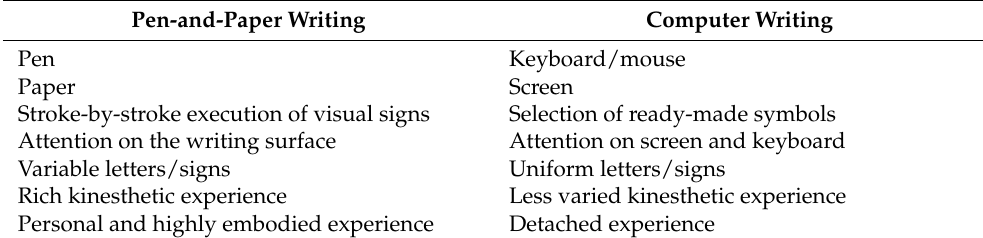
Table 1. Differences between pen and computer